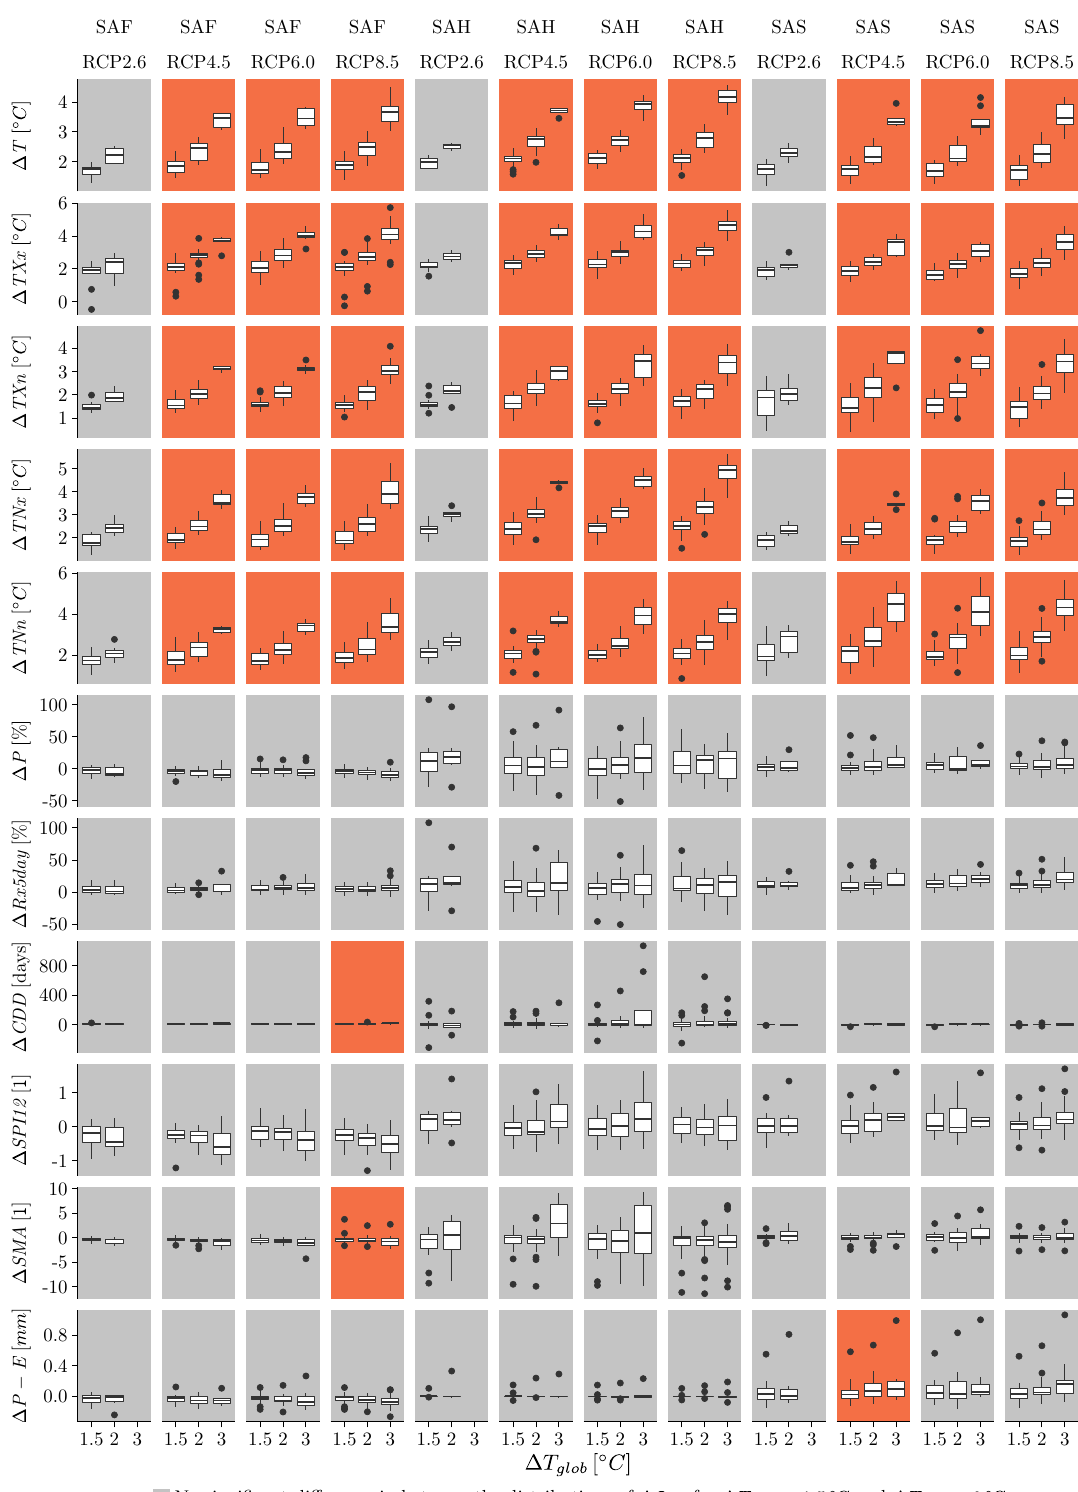
Figure A4. Like Fig. A1 but for SREX regions SAF, SAH, and